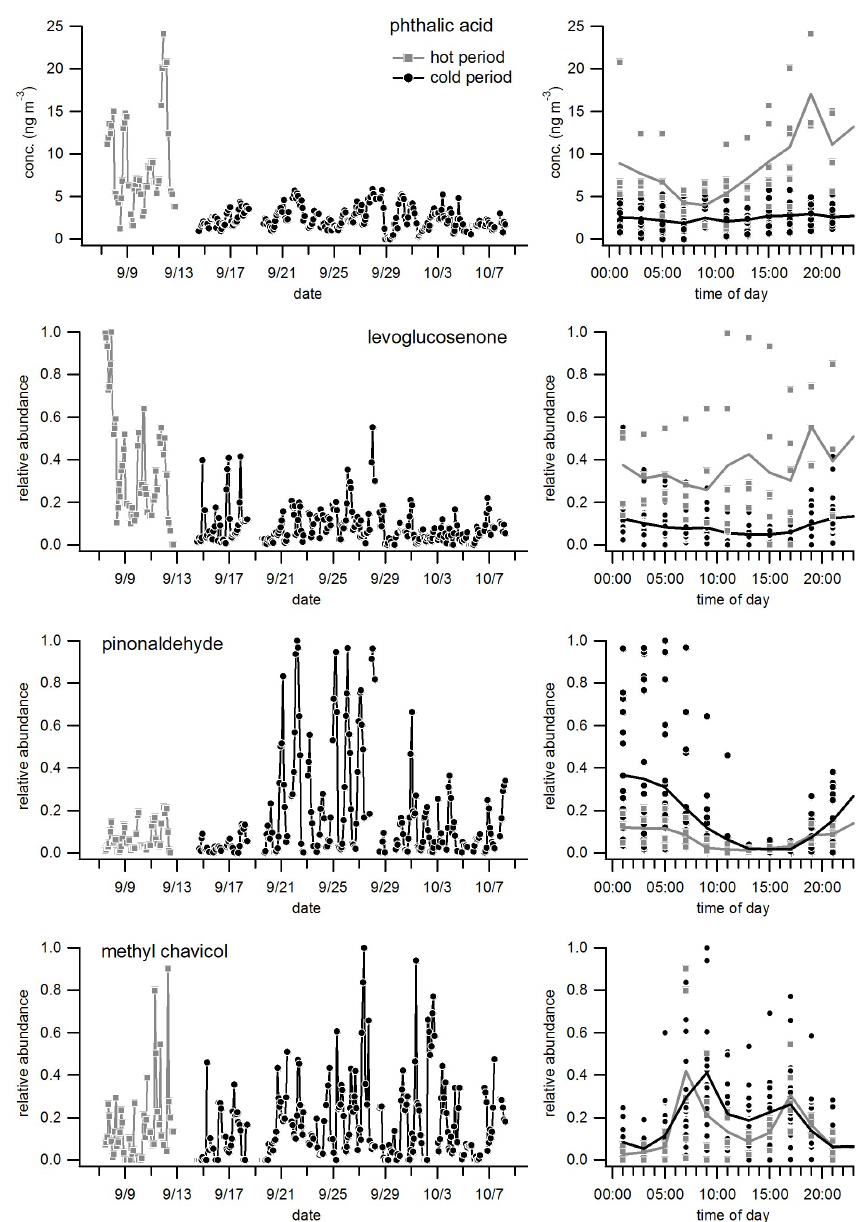
Fig. 6. Temporal and diurnal variations for the four major particle phase tracer compounds (1, 2 – phthalic acid; 1 – levoglucosenone; 3 – pinonaldehyde; 6 – methyl chavicol) that represent four of the six sources (1 – aged biomass burning emissions and oxidized urban emissions, 2 – oxidized urban emissions 3 – oxidation products of monoterpene emissions, and 6 – local methyl chavicol emissions and oxidation products), identified from a factor analysis, that impacted the site during both the identified meteorological